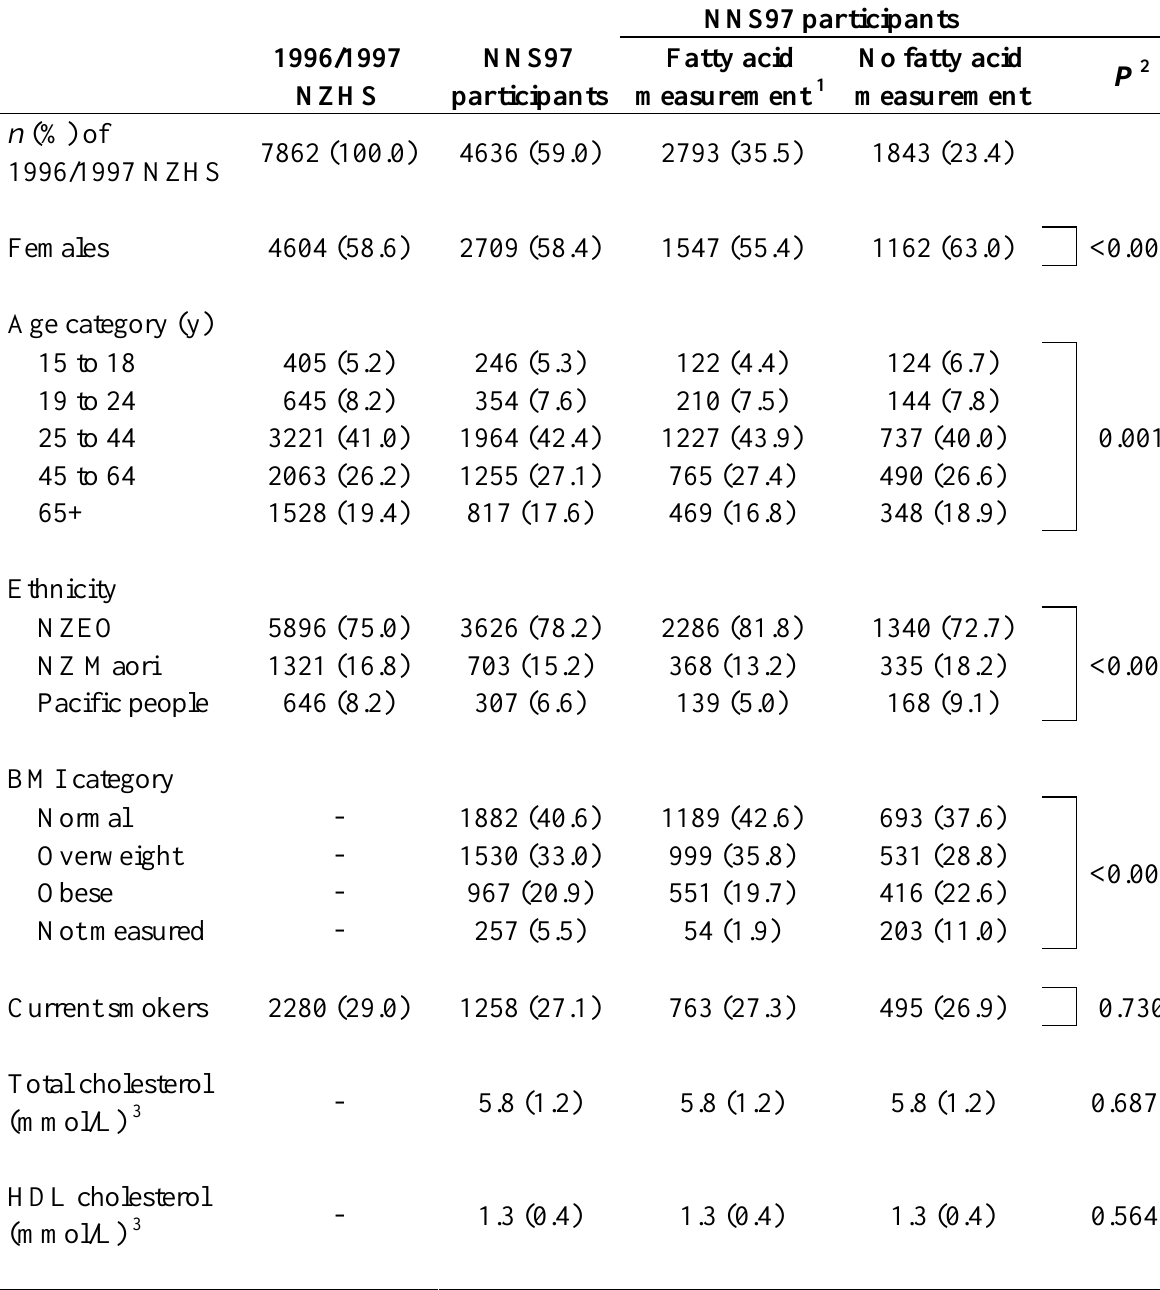
Table 2. Characteristics of the participants of the 1996/1997 NZHS and the 1997 National Nutrition